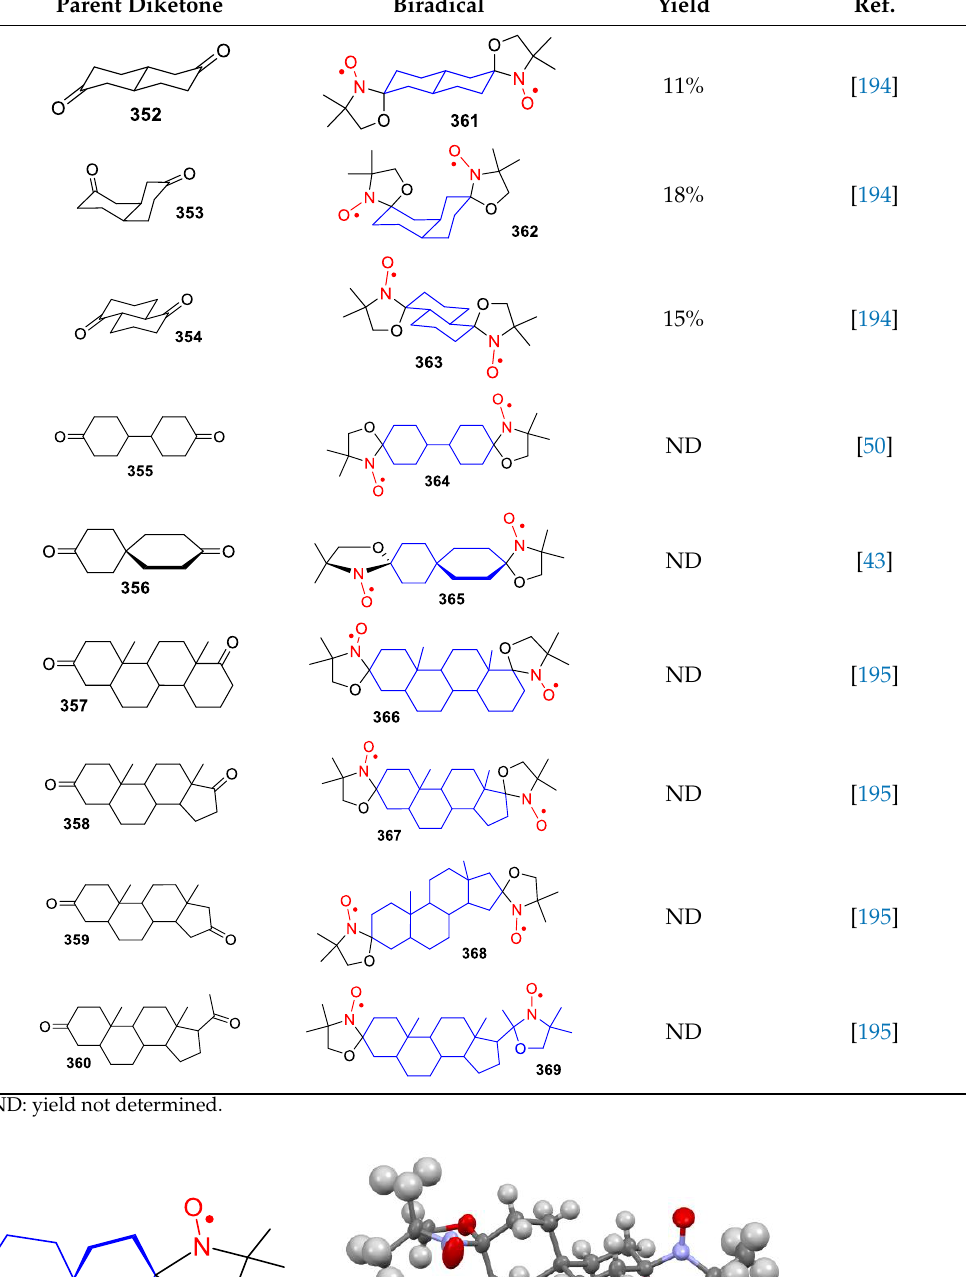
Table 3. Structures of available homo-SNBRs of the DOXYL type.